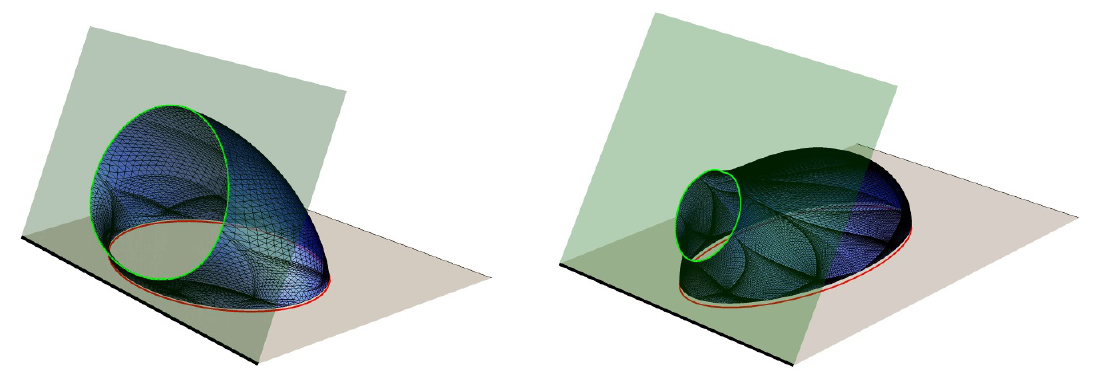
Figure 12 . Extremal surfaces ^ (cid:13) con found with Surface Evolver in the gravitational setup described A in section 2.2.1. The extremal surfaces are anchored to the boundary of two di(cid:11)erent ellipses A (red curves) and intersect orthogonally the half plane Q with (cid:11) = 2 (cid:25)= 3 (green half plane). Here " = 0 : 03. Denoting by R ? and R the lengths of the semiaxis which are respectively orthogonal k and parallel to the (cid:13)at boundary, and by d the distance of @A from the (cid:13)at boundary, we have d=R ? = 0 : 2 in both the panels. Instead, R = 2 R ? in the left panel and R = 0 : 5 R ? in the k k right